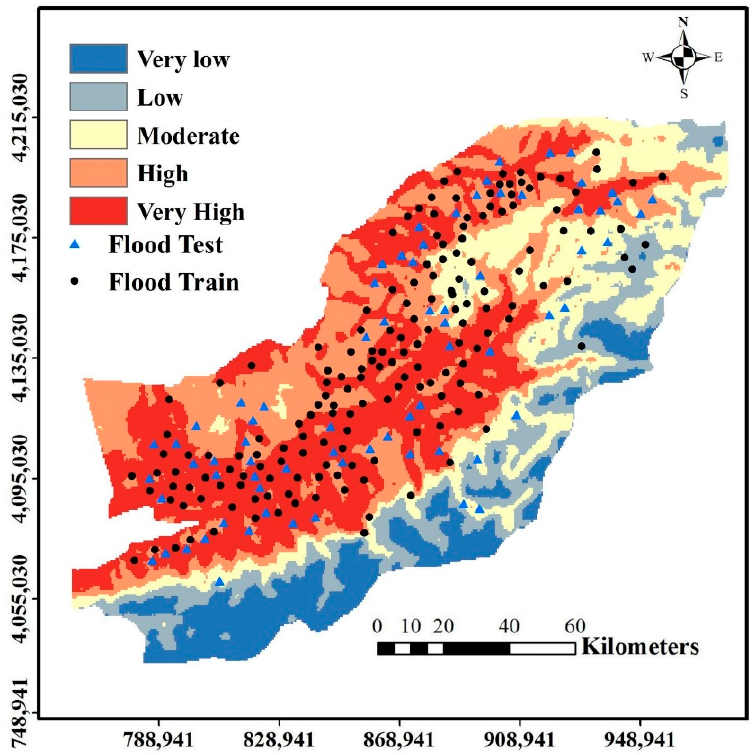
Figure 7. Flood zonation map of the study location (EDAS-WOE-AHP model).